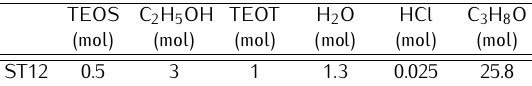
B Fig.2. Colour of the sols: A-after preparation, B-two weeks later